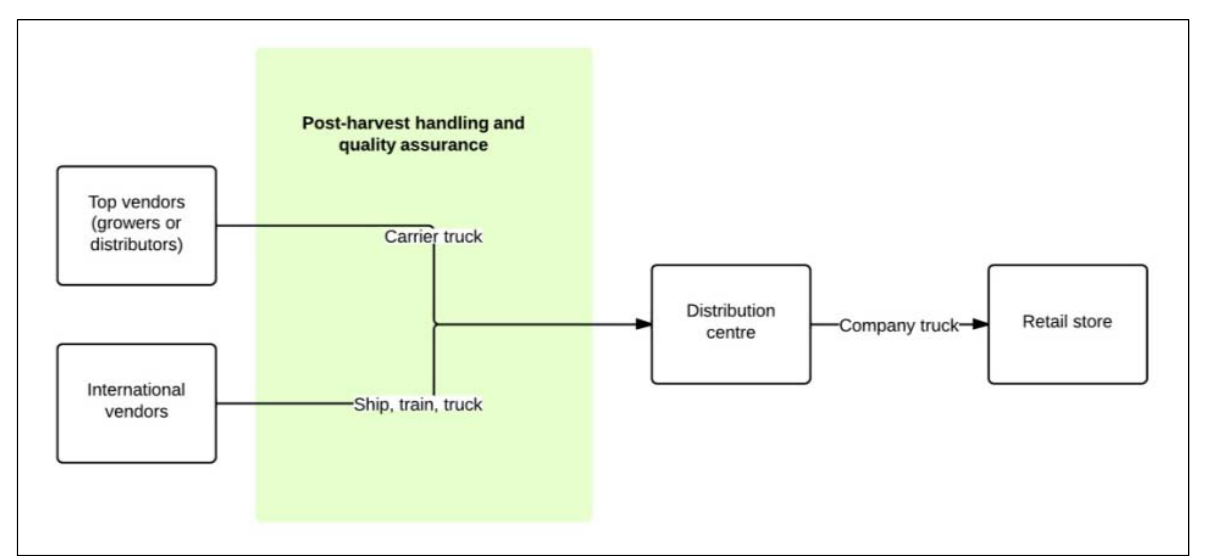
Figure 1. The Company’s Existing Supply